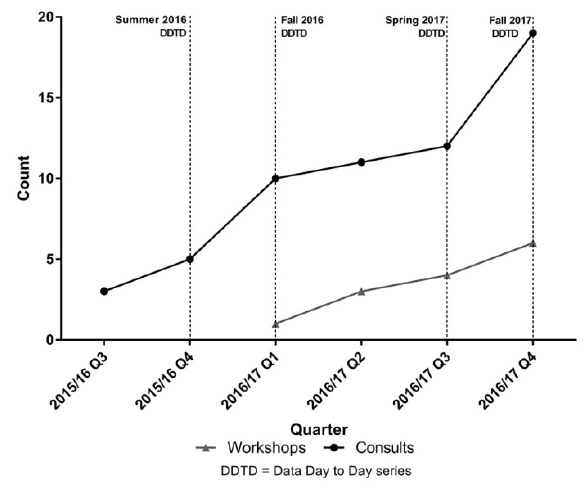
Figure 2 Consultations and workshops over